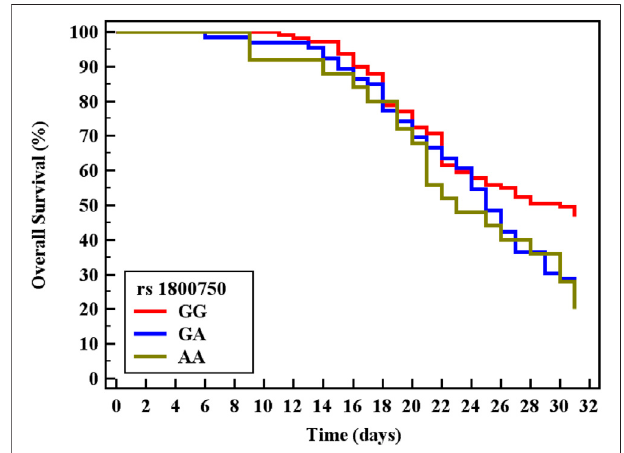
FIGURE2| Kaplan-MeiersurvivalcurveforOverallSurvivalwithCystCin total patients (No. (cid:1) 200).